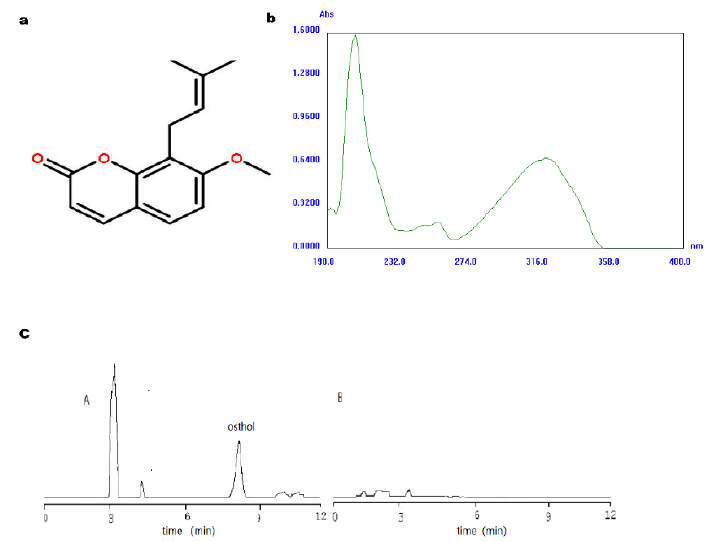
Figure 1. Structure, UV–Vis absorption spectrum, and HPLC chromatogram of osthol. ( a ) is chemical structure of osthol; ( b ) is the Uv absorption wavelength scan of osthol; ( c ) is the chromatogram of osthol sample (A) negative control (B).